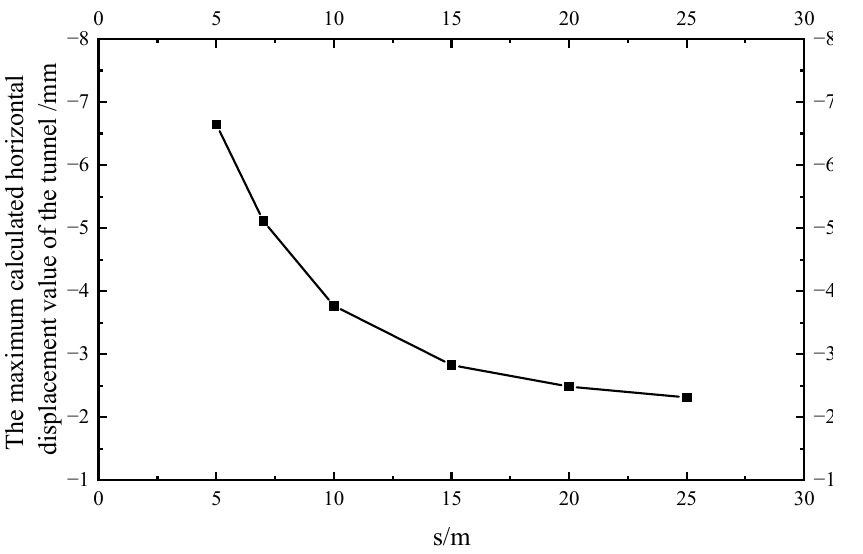
Figure 18. The calculated curve of the maximum horizontal displacement of the shield tunnel by the side of the foundation pit changing with s .